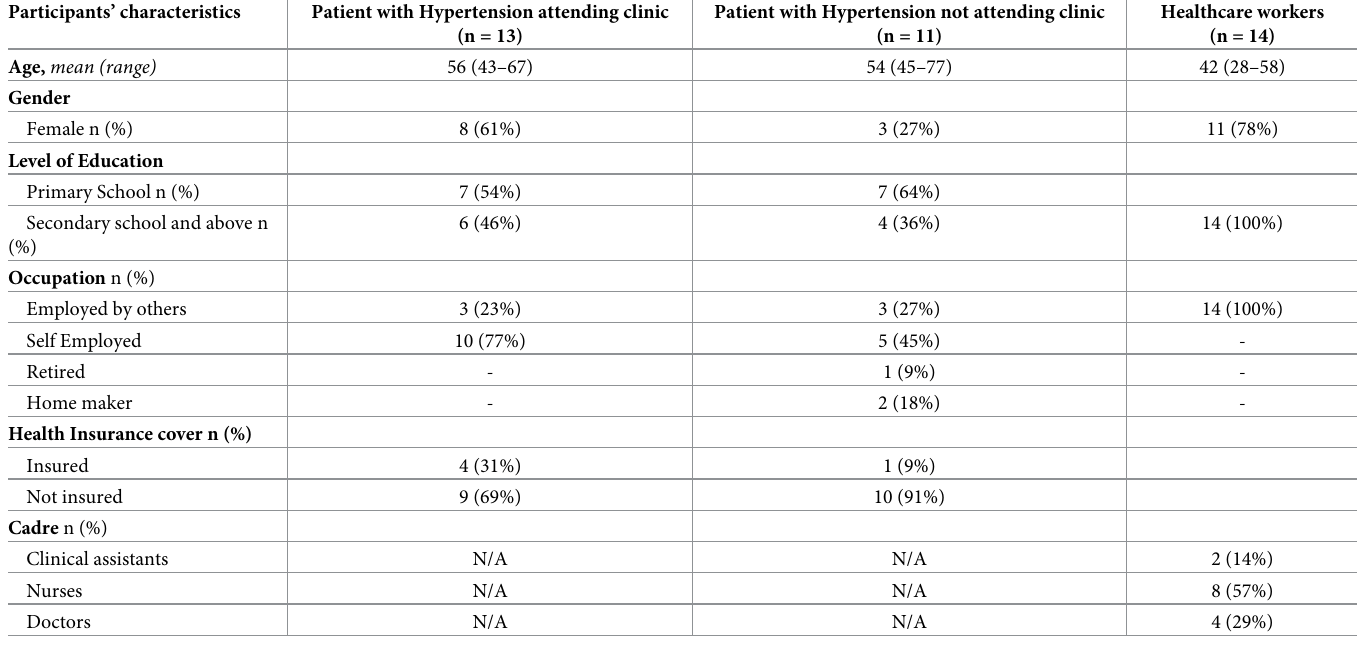
Table 1. Participant’s socio-demographic characteristics.